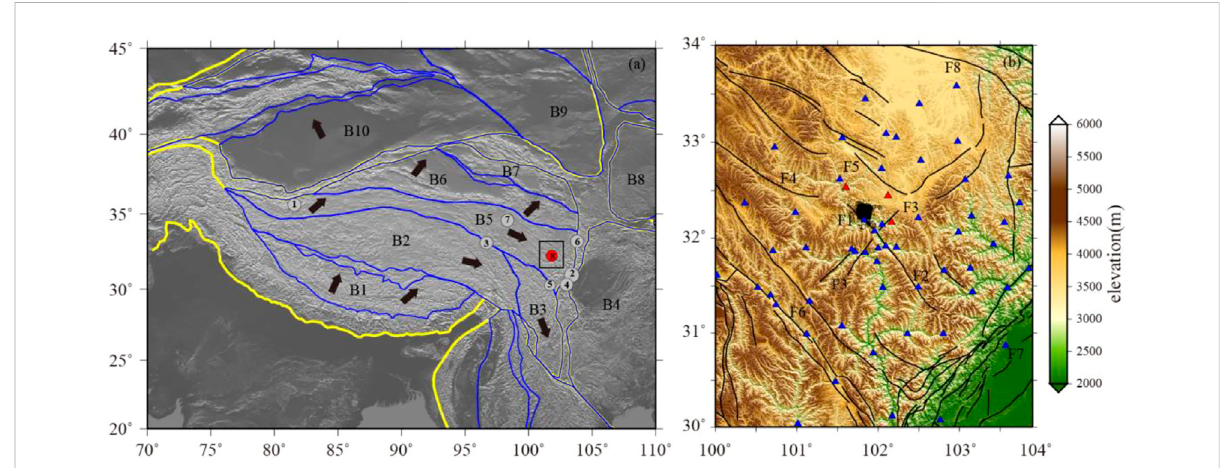
FIGURE 1 (A) Geological setting of the Qinghai – Tibet plateau and the surrounding region. Solid yellow and blue lines indicate the block and sub-block boundaries,respectively, and thebluepolygon B5 de fi nes thebayan har block(Zhang etal.,2003).Numberedcircles denotethe M s ≥ 6 earthquakes that have occurred in the region since 2007, which are described in the introduction orderly. The solid black arrows represent the movement directions of the blocks. The black box indicates the study region, which is shown in (B) . B1: Lhasa block. B2: Qiangtang block. B3: Sichuan – Yunnan block. B4: South China block. B5: Bayan Har block. B6: Qaidam block. B7: Qilian block. B8: Ordos block. B9: Alashan block. B10: Tarimblock. (B) Activefaultsandseismicityassociatedwiththe2022 M s6.0Maerkangearthquakesequenceinthestudyregion.Blackcirclesdenote earthquakes that occurred during the Maerkang M s6.0 earthquake sequence. Blue and red triangles represent the permanent and temporary (portable) seismometer locations. F1: Songgang fault. F2: Fubianhe fault. F3: Longriba fault. F4: Dari fault. F5: Aba fault. F6: Xianshuihe fault. F7: Longmenshan fault. F8: eastern Kunlun